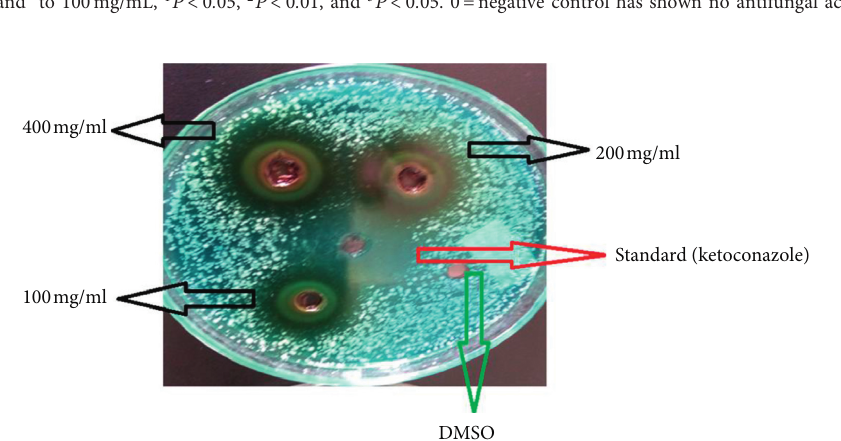
Figure 1: ZI of the leaf exudate of Aloe megalacantha against clinically isolated C. krusei .